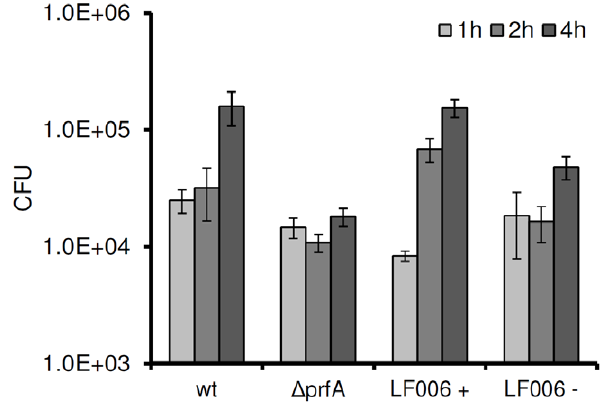
Figure 6. Intracellular multiplication of prfA -negative and P rha - dependent trans-complemented L.monocytogenes after infec- tion of human THP1 macrophages. wt: wild type; D prfA : prfA knock out; LF006 + : single copy prfA under control of P rha (pre-induced overnight with 10 mM rhamnose); LF006 2 : non-induced.